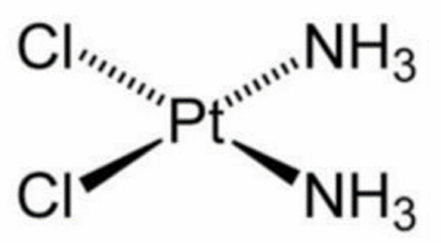
Figure 1. Chemical structure of cisplatin drug